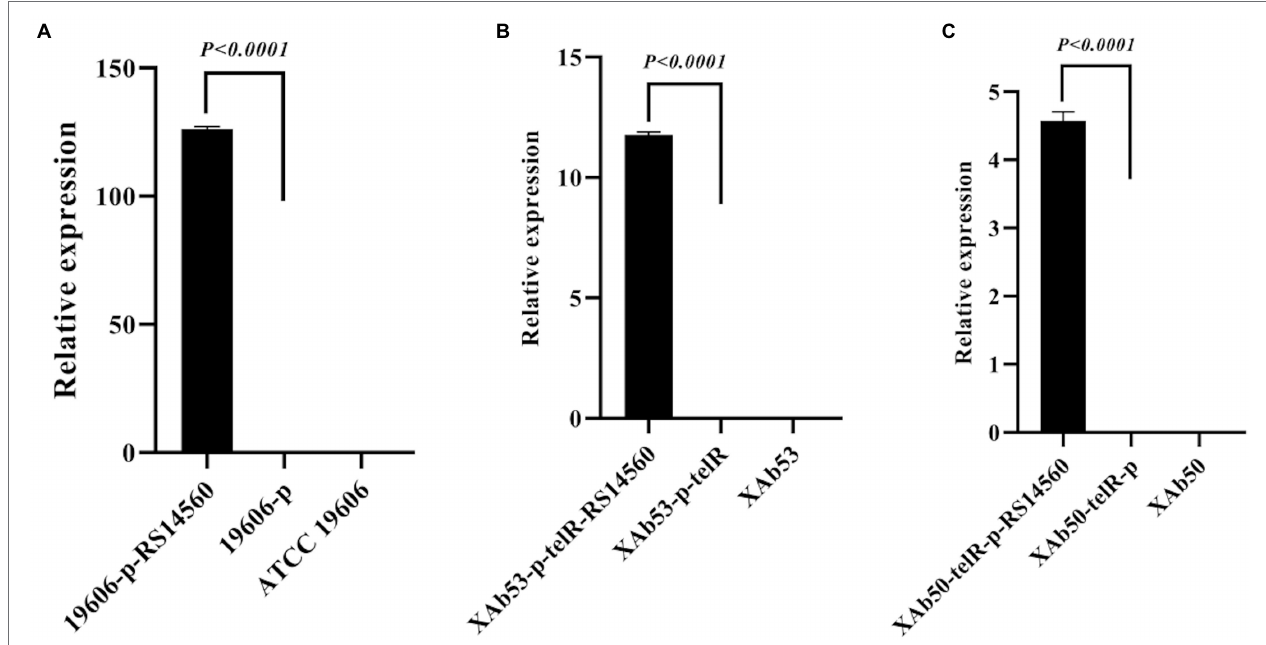
FIGURE 2 | Relative expression of BIT33_RS14560 by qRT-PCR. The x -axis represents the A. baumannii strains, and the y -axis represents the relative mRNA levels of BIT33_RS14560 (2 – △ CT ). p < 0.05 indicates a statistical significance. (A) Overexpression of ATCC 19606 strain; (B) Overexpression of XAb53 isolate; and (C) Overexpression of XAb50